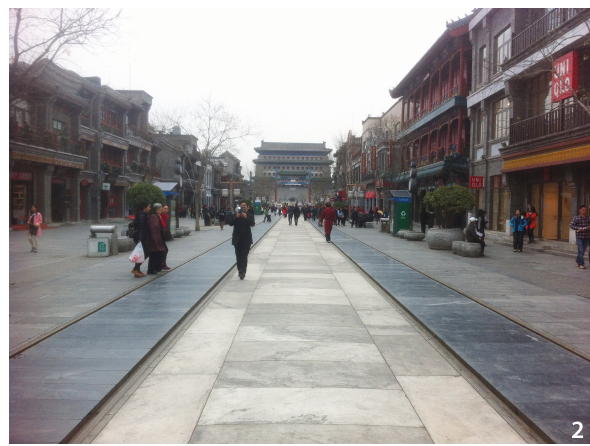
Figure 2 Qianmen Street, Beijing. (Source: the author, 2015)